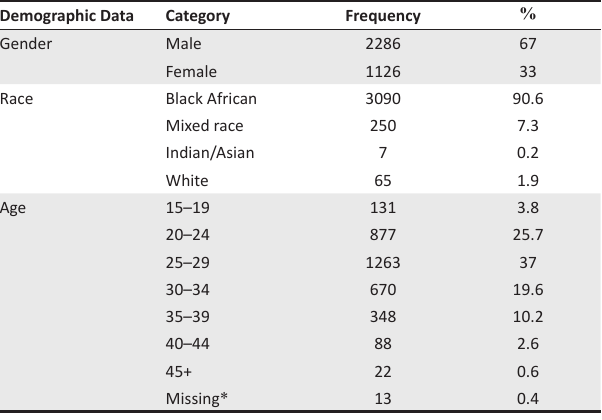
TABLE 4: Demographic profile of the applicants.